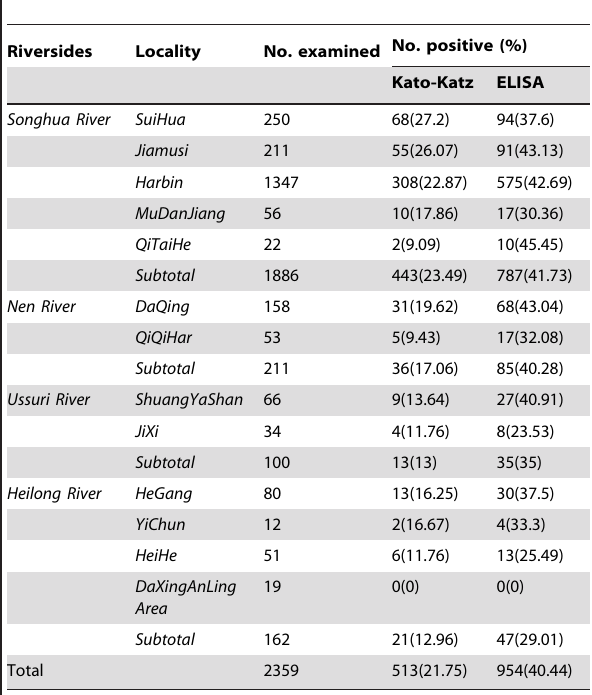
Table 4. Regional distribution of Clonorchis sinensis infection in Heilongjiang Province by Kato-Katz and ELISA